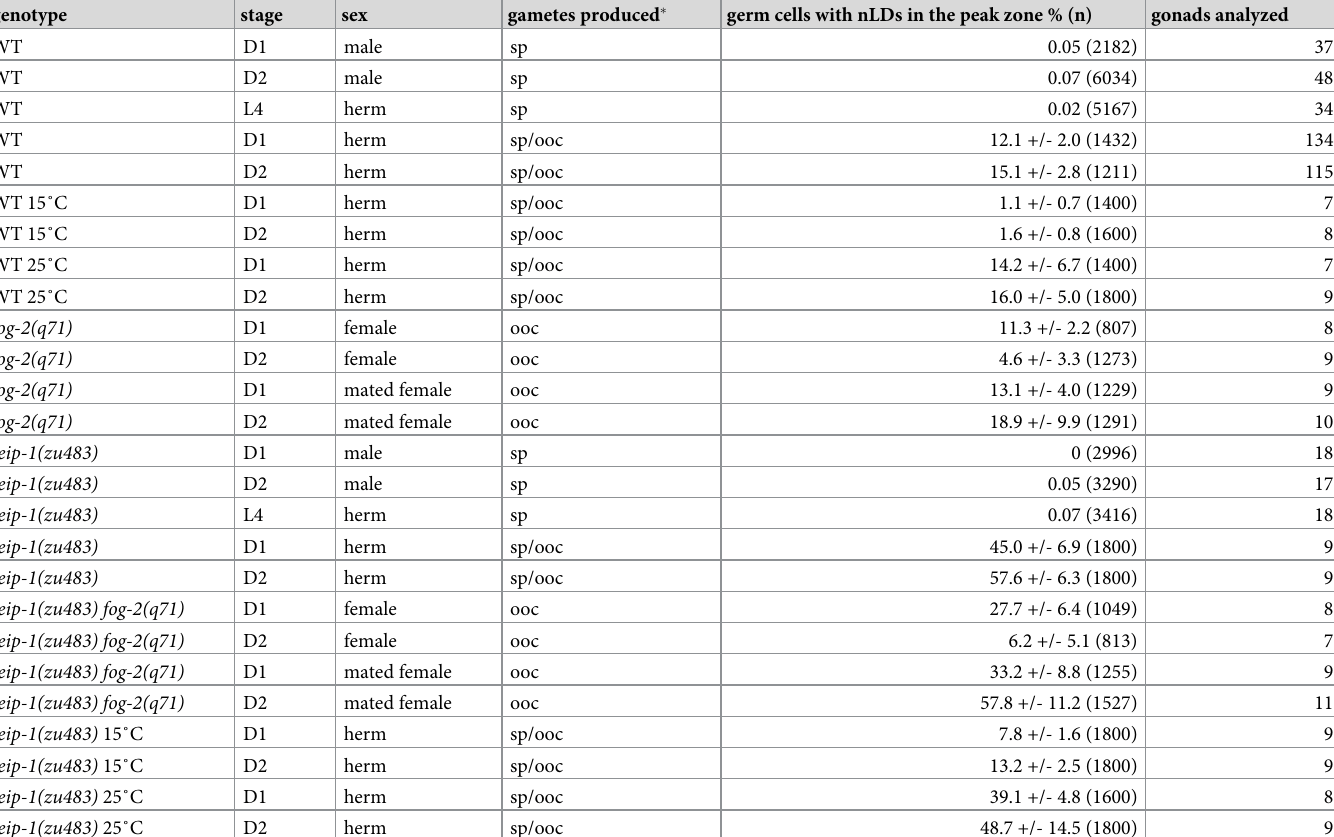
Table 3. Germ cell